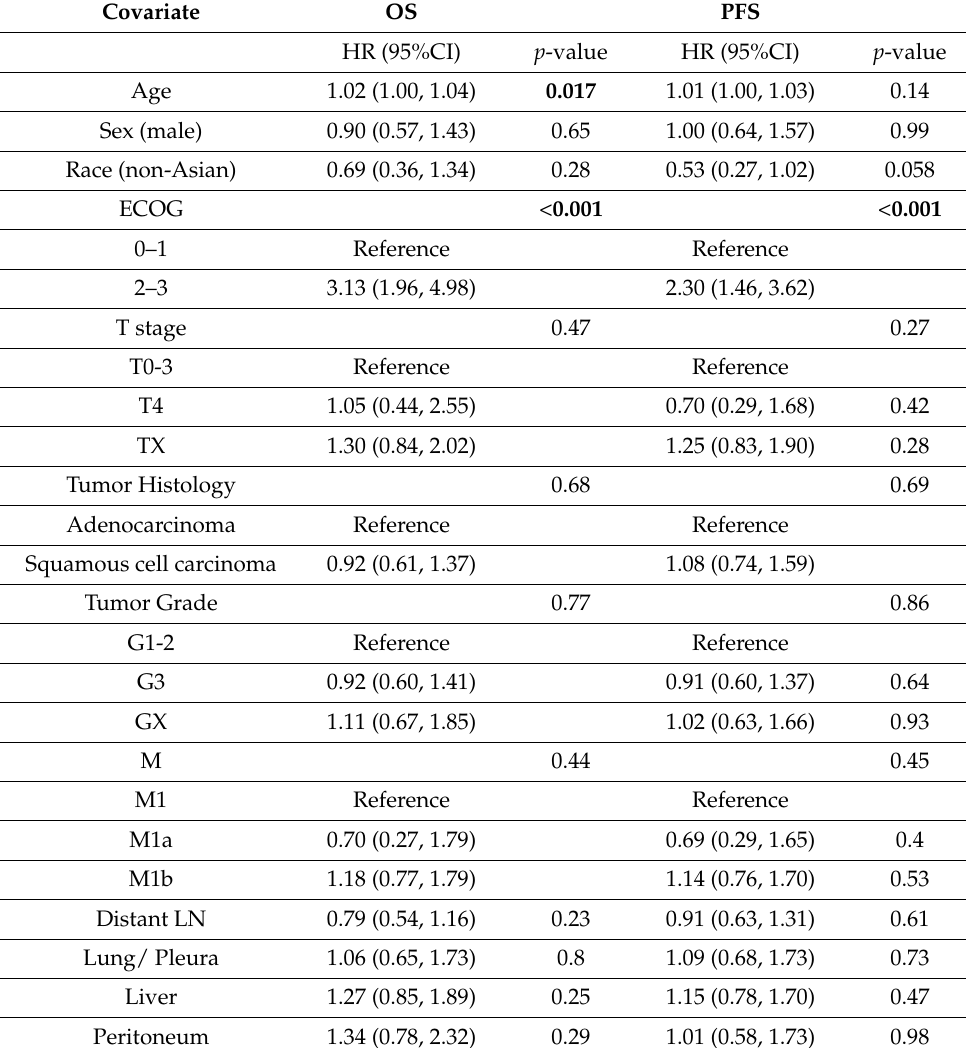
Table 3. Univariable Cox regression analysis for OS and PFS in the overall cohort. Covariate